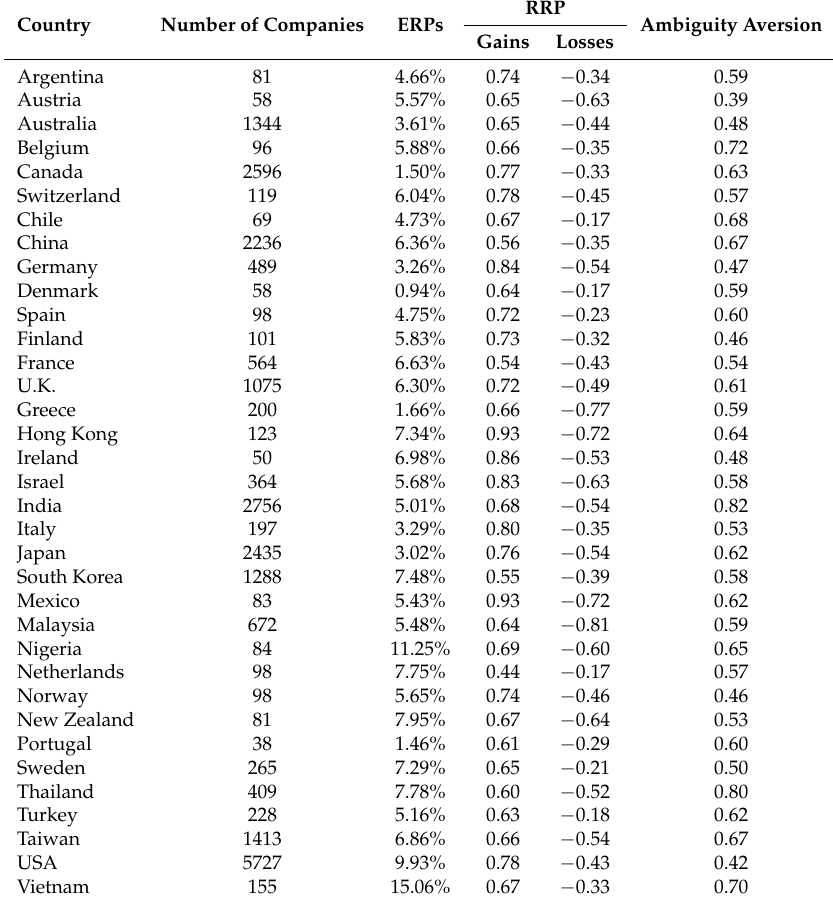
Table 3. Equity premia, ambiguity aversion and risk